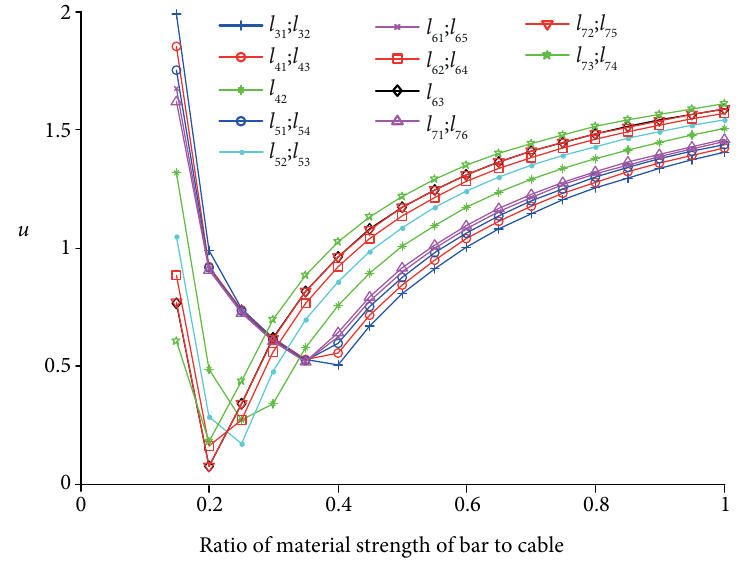
Figure 9. The relationship between parameter u and the ratio of material strength of bar to cable. In Eq. 22, the parameter u is used to represent the utilisation ratio of material strength. When the parameter u is close to 0, the utilisation of material strength is high. Figure 9 shows that, for the first and ( p -1)th configurations of each tensegrity structure, the parameter u is large in the interval. When the ratio of material strength of bars to cables is 0.4, the utilisation ratio of material strength of the structure reaches the highest. Compared with the two configurations above, the utilisation ratio of material strength of other configurations is greatly improved. When the ratio of material strength of bars to cables is 0.2, the utilisation ratio of material strength of the structure reaches the